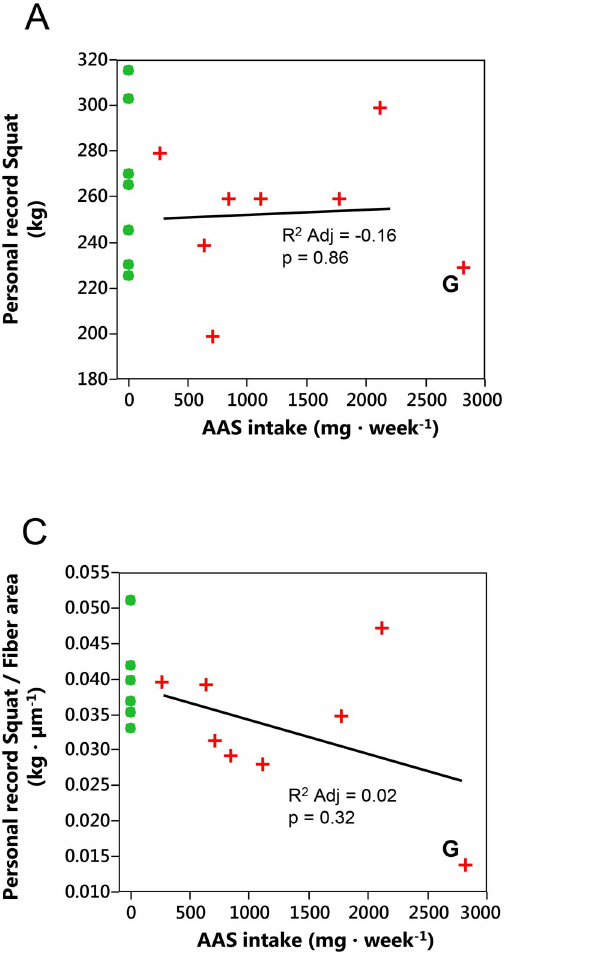
Figure 2. Regression models for the effects of AAS intake on muscle performance. Correlations between AAS weekly intake and muscle performance: A) personal record (kg; R 2 = 2 0.16, p=0.86) and B) maximal squat force (N; R 2 =0.34, p=0.06), and models for the effects of AAS intake on relative muscle performance: C) maximal squat force per lean leg mass (N˙g 2 1 ; R 2 =0.02, p=0.32) and D) maximal squat force per fiber area (N˙ m m 2 1 ; R 2 = 2 0.14, p=0.98). The residual of subject G is outlier (p=0.003, Shapiro-Wilk W test) and when removed, the regression is significant between force per fiber area and AAS intake (N˙ m m 2 1 ; R 2 =0.57,